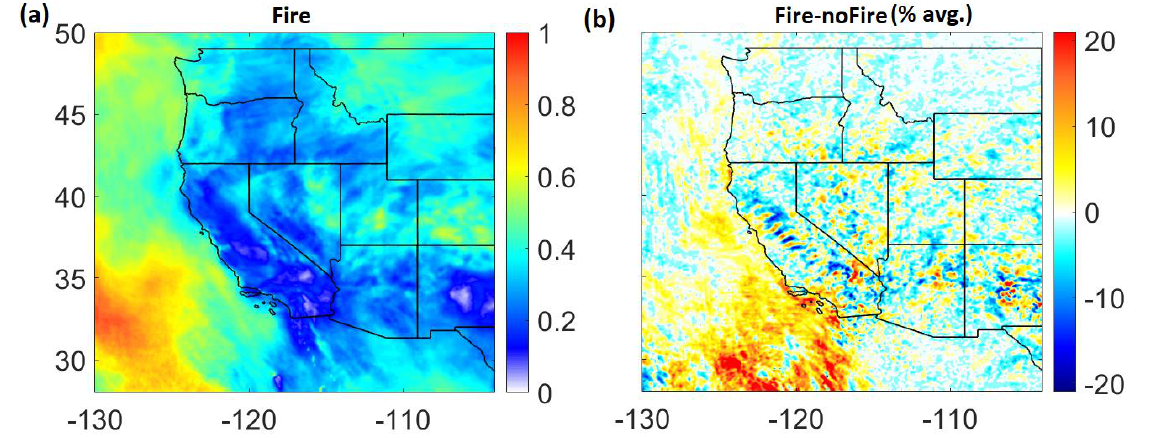
Figure 10. Spatial distribution of average ( a ) cloud cover from ‘Fire’ simulation, and ( b ) percentage difference between the ‘Fire’ and ‘noFire’ simulations relative to the ‘noFire’ simulation for the first half of September 2017.